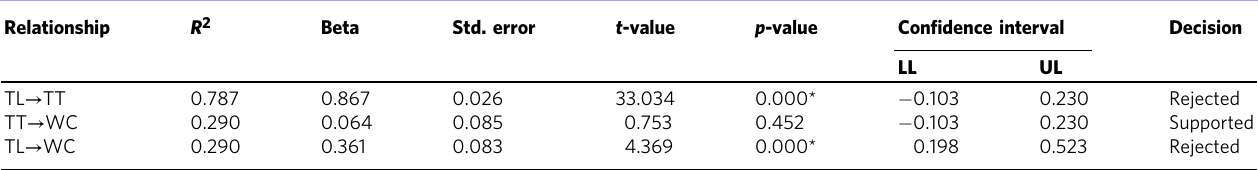
Table 9 Mediation analysis